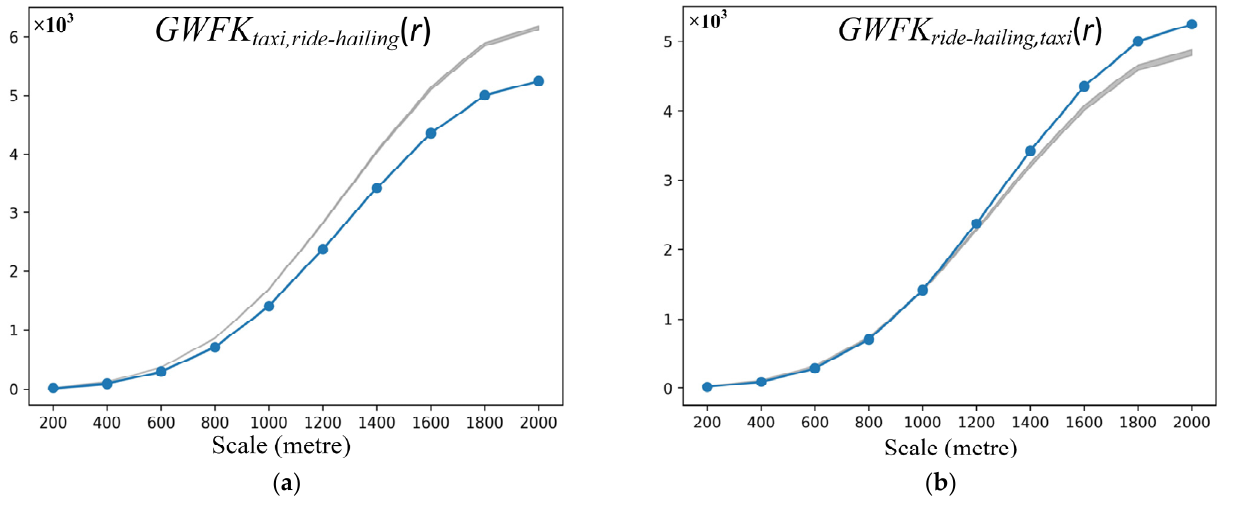
Figure 8. Results of global geographically weighted Flow Cross K-Function: ( a ) spatial association between taxi and ride-hailing; ( b ) spatial association between ride-hailing and taxi.